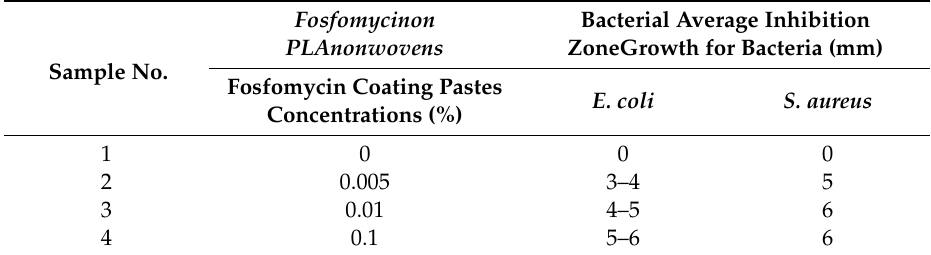
Table 7. Results of tests on the antibacterial activity of fosfomycin modified nonwovens.